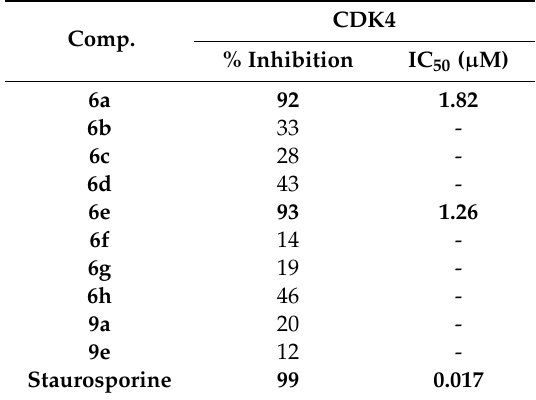
Table 5. Inhibitory e ff ect of compounds 6a–h , 9a , and 9e on CDK4 at a single-dose of 20 µ M, and IC 50 values of the most potent compounds 6a and 6e.